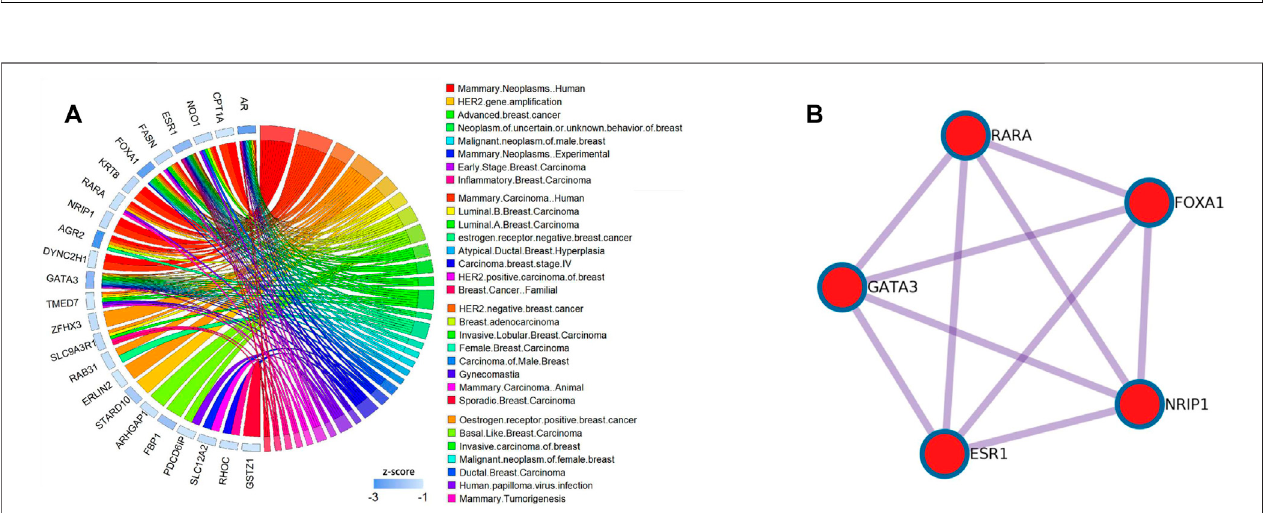
FIGURE 5 | Results of the DisGeNET dataset and PPI pathways of the Basal subtype in the BCI dataset; (A) relationship between the diseases and gene selected by the DM-ESPCA model of the Basal subtype in the BCI dataset.The blue bar shows the z-score of each gene.Data collected from the DisGeNET dataset. (B) KeyPPI pathways of part of the gene selected by the DM-ESPCA data